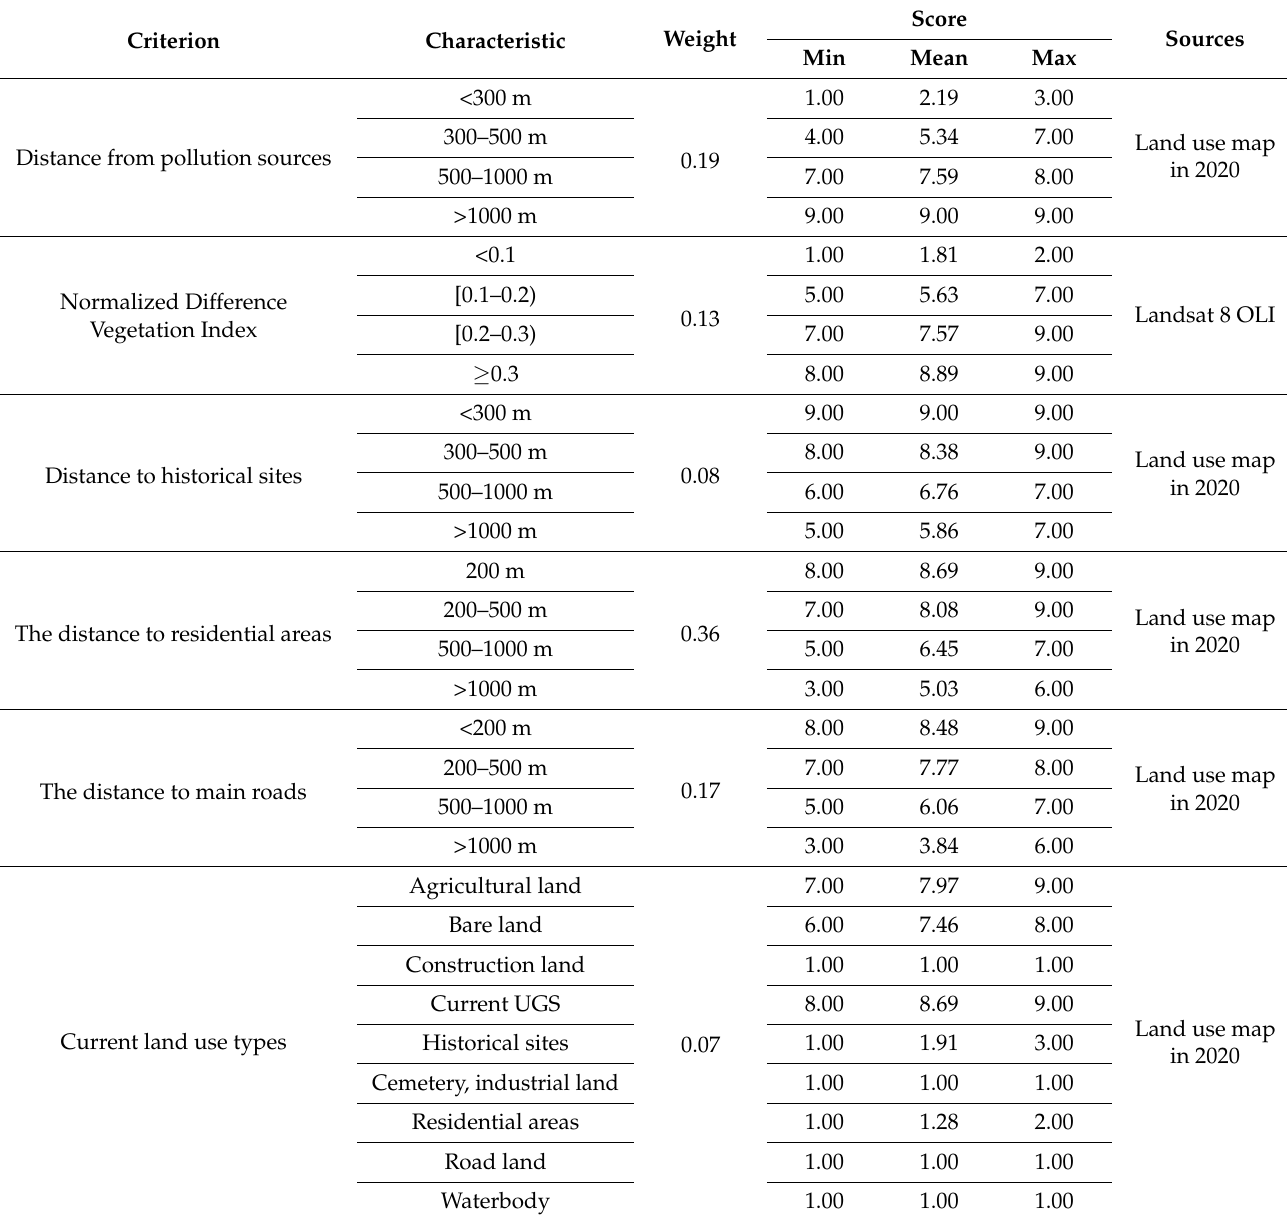
Table 1. The criteria and their characteristics for